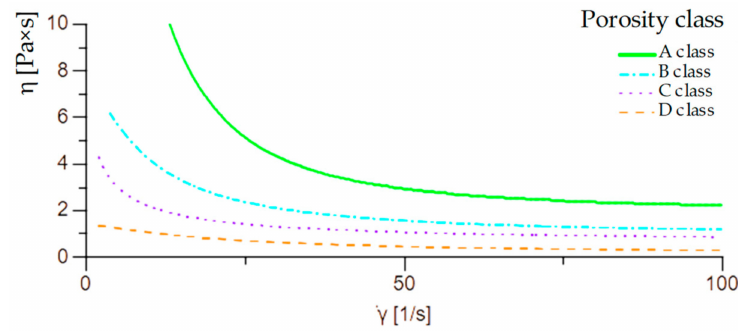
Figure 5. Dynamic viscosity versus shear rate of the four foam